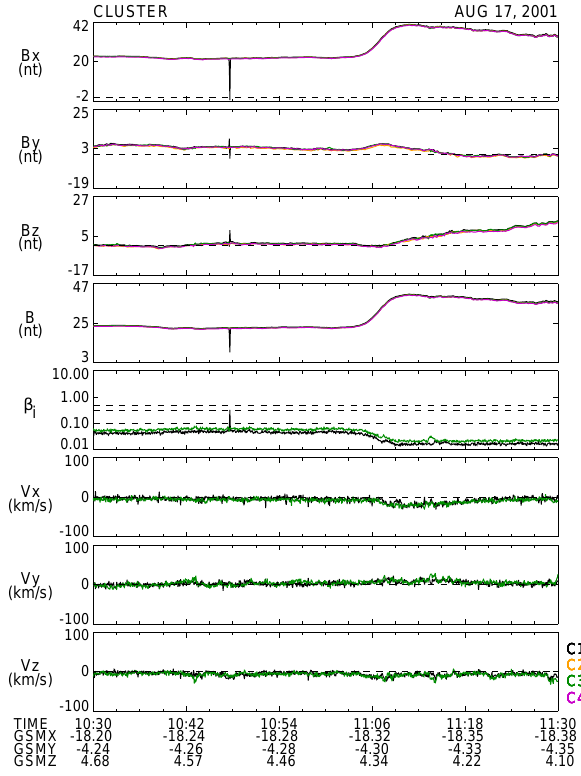
Fig. 3. Cluster FGM and CIS (from C1 and C3) observations for the tail lobe SI event observed on 17 August 2001 over a 1-h interval. Panels show magnetic field components in the GSM coordinate sys- tem, the magnetic field intensity, plasma beta, and the components of the